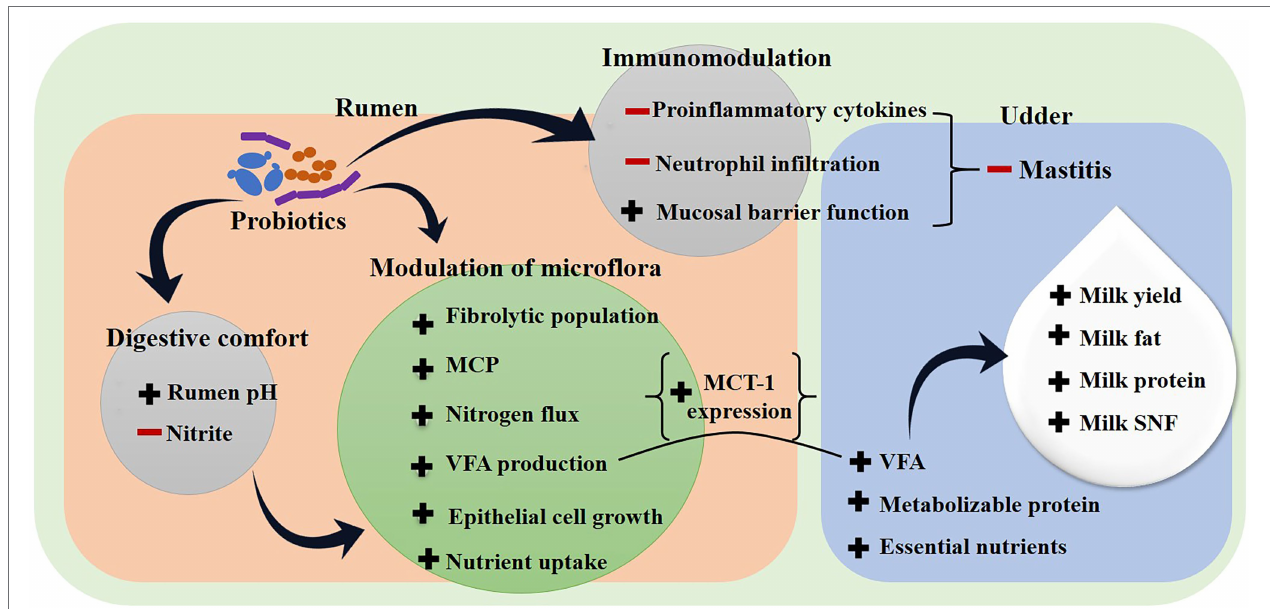
FIGURE 3 | Effect of probiotics to improve milk productivity in dairy animals. ( − ) Sign indicates inhibition, ( + ) sign indicates enhancement, MCP: microbial crude protein, SNF: slid not fat, VFA: volatile fatty